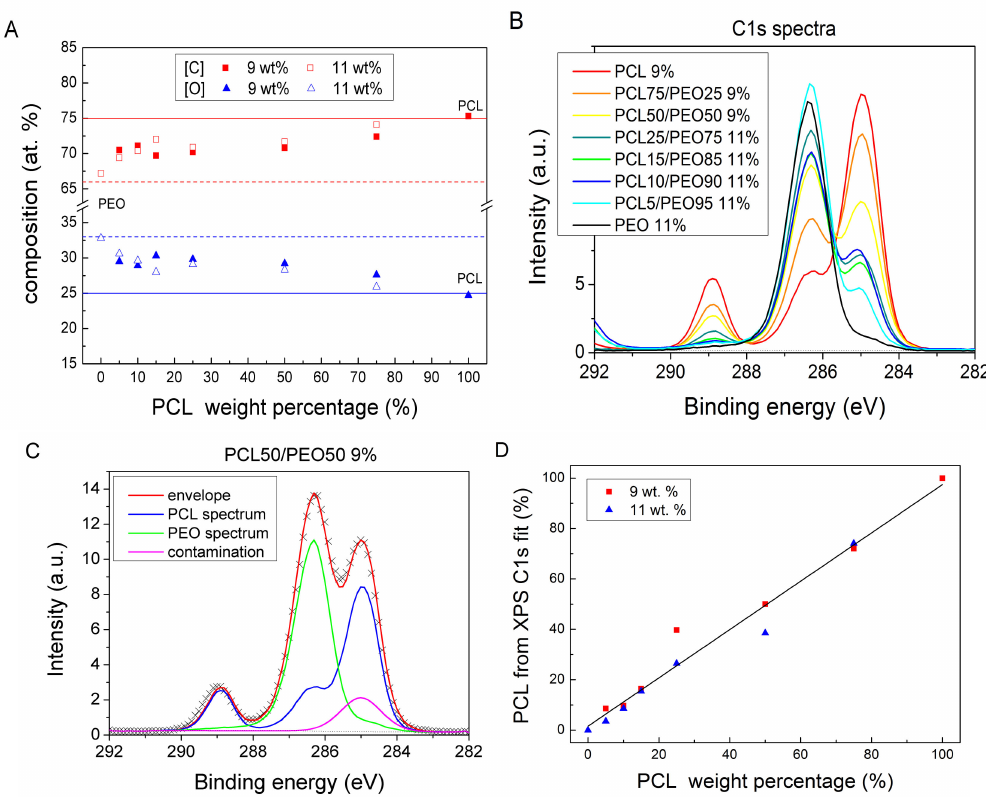
Figure 1. Analyses of PCL / PEO nanofibrous mats by XPS: ( A ) elemental composition in dependence on the PCL weight percentage, ( B ) high-resolution C1s XPS spectra of PCL, PEO and PCL / PEO mats, ( C ) example of C1s fitting using the model based on pure PCL, PEO and aliphatic carbon contamination components, and ( D ) linear relation between the PCL concentration in the mats (obtained by fitting C1s data) and the PCL weight percentage in the electrospinning PCL / PEO mixture.